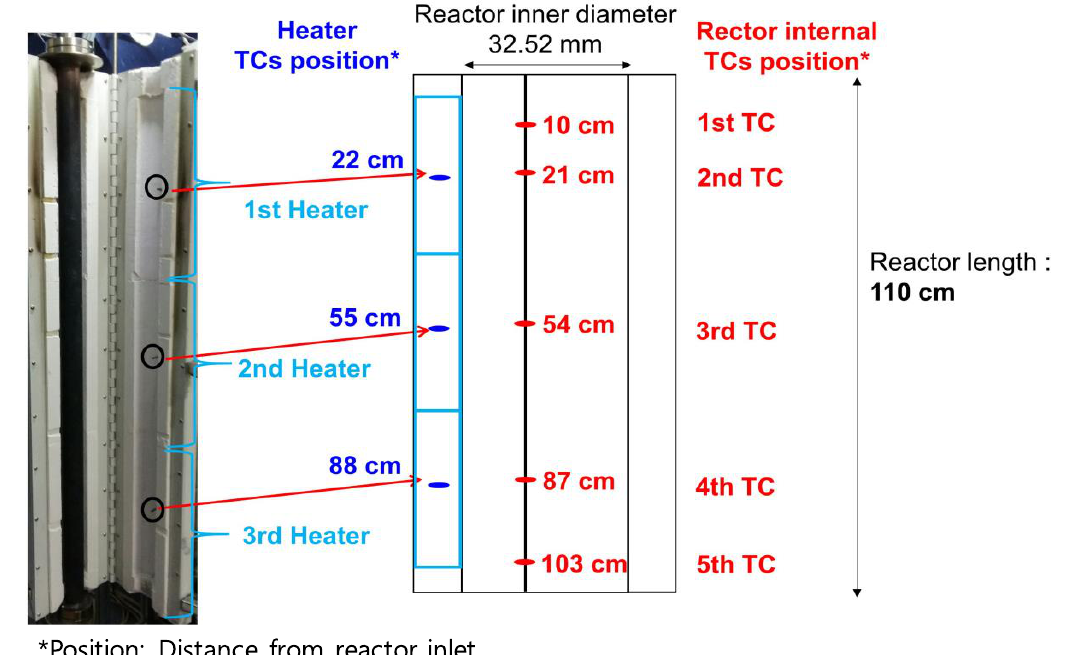
Figure 9. Detailed position of the heaters and TCs in the bench-scale reactor.